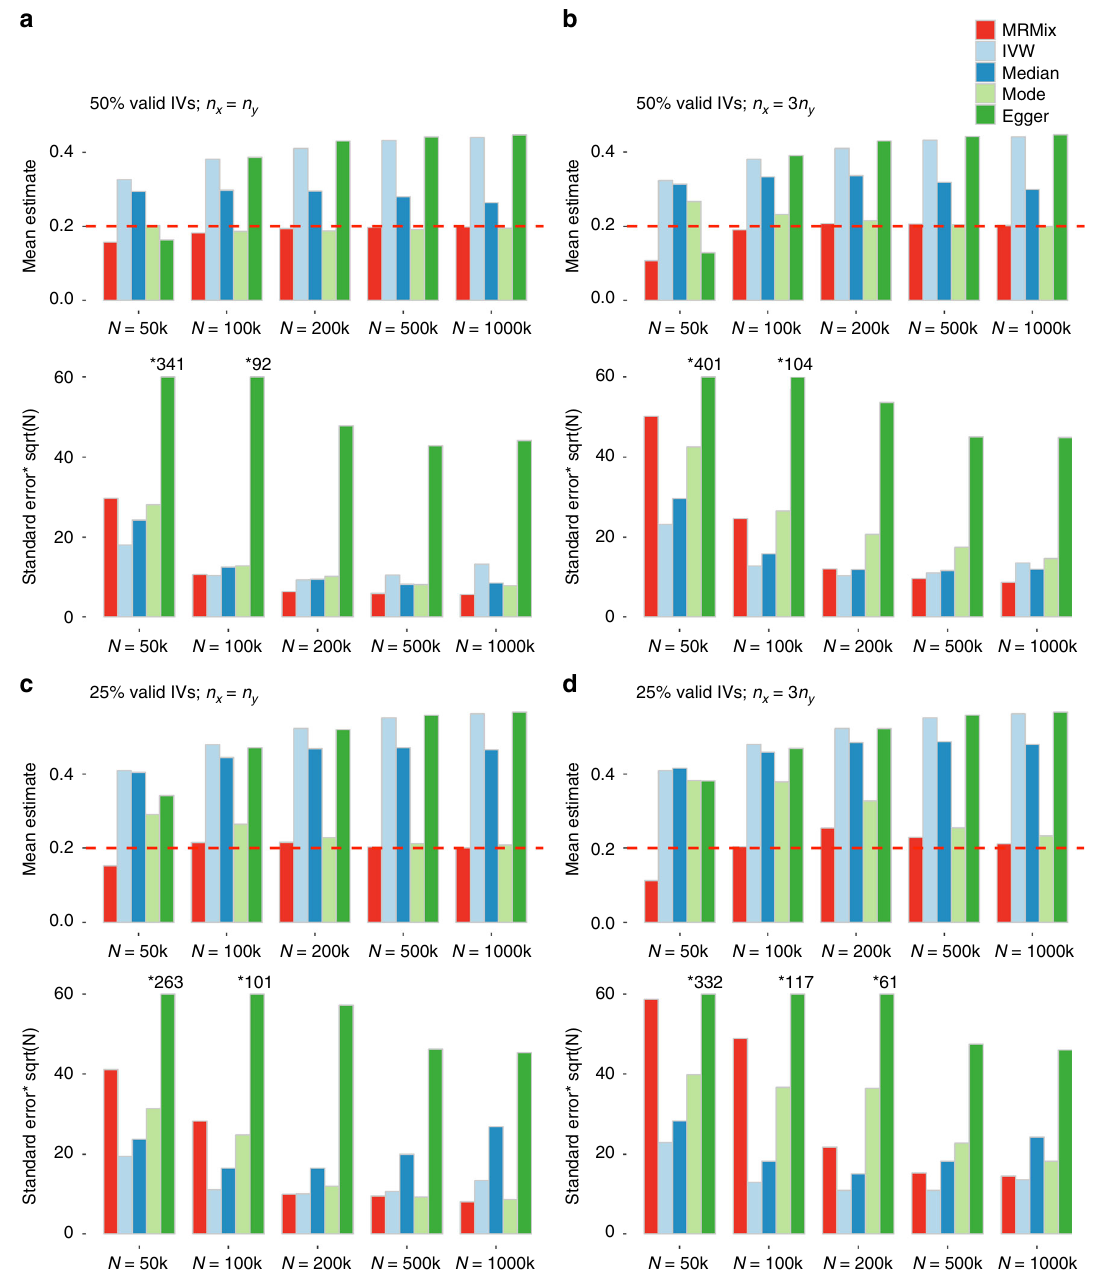
Fig. 2 Simulation results when genetic correlation due to causal and pleiotropic effects are in the same direction. Mean and standard deviation of causal estimates are reported over 100 simulations. The true causal effect θ is 0.2. Estimates of association coef fi cient for SNPs across two traits are simulated assuming an underlying four-component model for effect-size distribution (Scenario A, see Methods), where SNPs could have direct effects on neither traits, only on X , only on Y , or on both with the effects being correlated. The proportion of valid instruments, i.e., the SNPs which have only direct effects on X , as a proportion of the total number of SNPs which are associated with X , are fi xed at 50% or 25%. n x = N : sample size of the study associated with X ; n y : sample size of the study associated with Y . Standard error bars higher than 60 are truncated and marked with *true-value. The average number of IVs, de fi ned as the SNPs which reach genome-wide signi fi cance (z-test p < 5 × 10 − 8 ) in the study associated with X , is 14, 105, 399, 1135, and 1780 for N = 50 k, 100 k, 200 k, 500 k, and 1000 k, respectively. Source data are provided as a Source Data fi